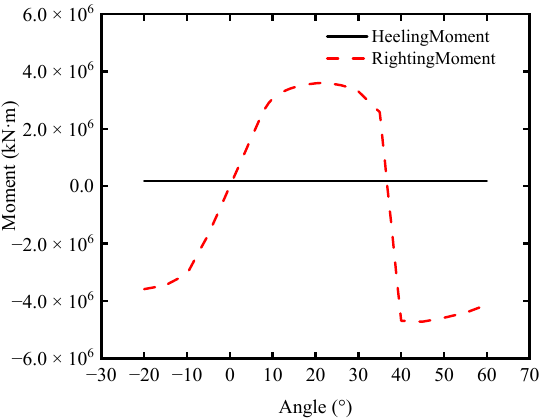
Figure 5. The wind heeling moment and righting moment of LSBT-FOWT-AC.